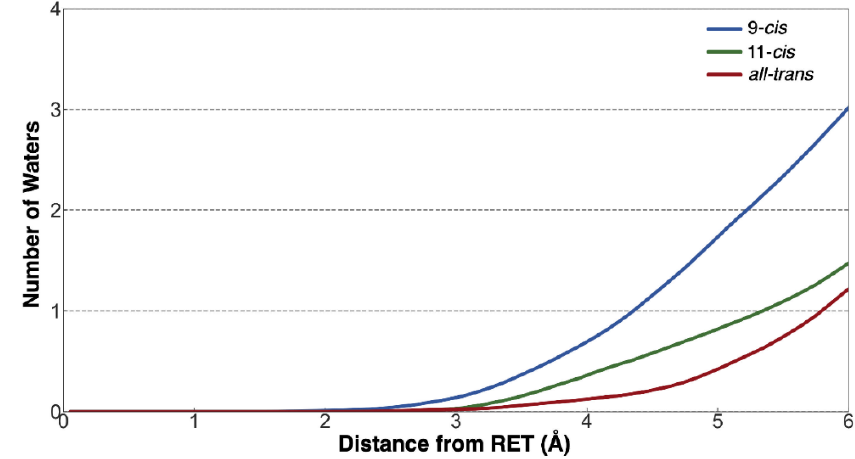
Figure 4. Integrated radial distribution function of waters from the chromophore using the 1-ns QM/MM MD trajectories.